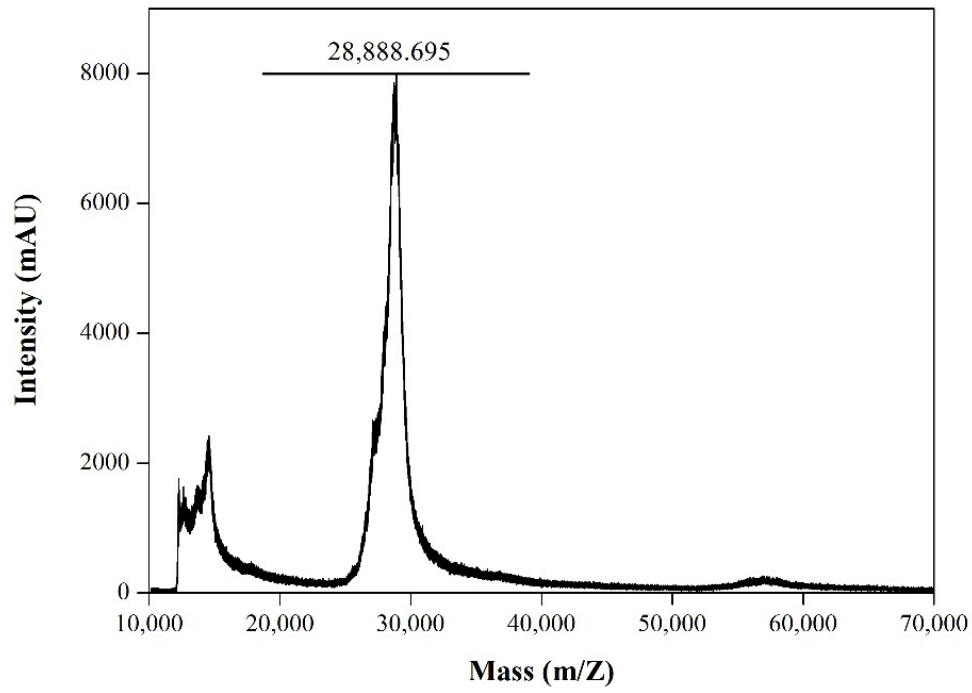
Figure 5. MALDI-TOF MS analysis of purified rRBD.